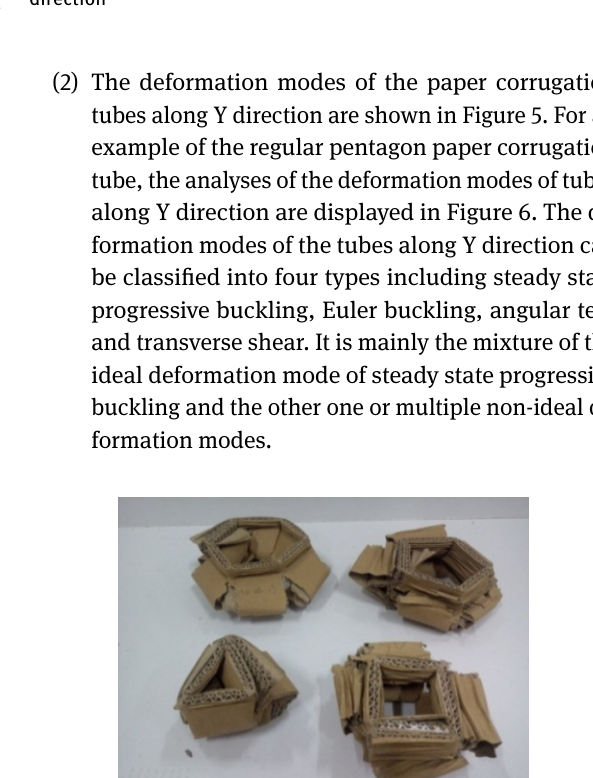
Figure 4: Deformation mode of paper corrugation tube along X direction